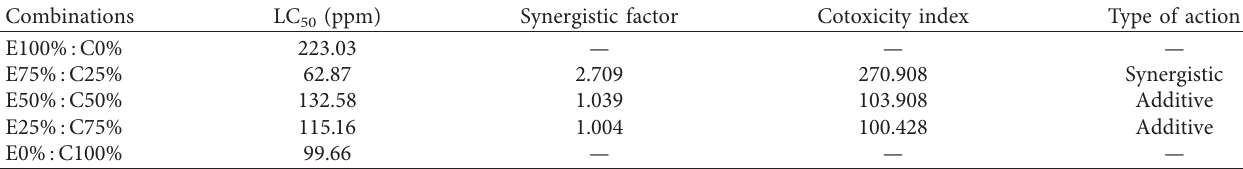
Table 6: Synergistic factor and cotoxicity index of the combination of the essential oils of E. camaldulensis and C. rigidus. Combinations LC 50